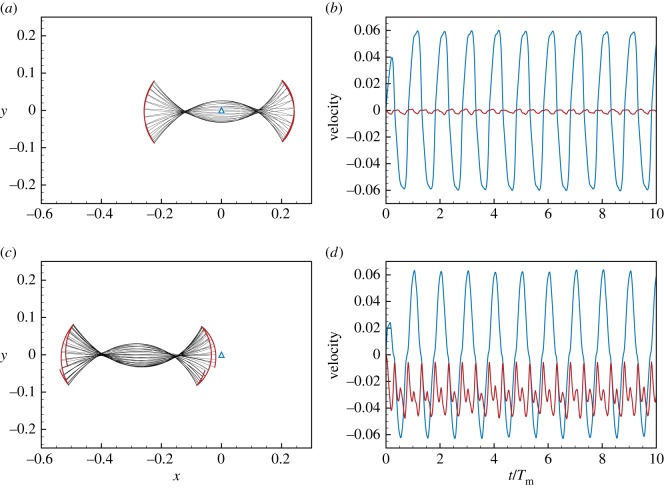
Isotropic versus anisotropic friction driven locomotion. (a) Gait envelope computed over the 10th muscular activation cycle in the case of isotropic friction. The blue triangle denotes the location of the snake’s centre of mass at time t=0, reported as reference. (b) Lateral (blue) and forward (red) velocities as functions of time normalized by the activation period Tm in the case of isotropic friction. (c) Gait envelope computed over the 10th muscular activation cycle in the case of anisotropic friction. The blue triangle denotes the location of the snake’s centre of mass at time t=0, reported as reference. (d) Lateral (blue) and forward (red) velocities as functions of time normalized by the activation period Tm in the case of anisotropic friction. Settings: length L=0.5 m, radius r= 0.025 m, mass m=1 kg, Young’s modulus E=107 Pa, shear modulus G=2E/3 Pa, shear/stretch matrix S=105×1 N, bend/twist matrix B=diag(EI1,EI2,GI3) Nm2, dissipation constant γ= 10−1 kg (ms)−1, gravity g=9.81 m s−2, static μfs=0.2, μsr=μsf, μsb=μsf and kinetic μfk=0.1, μkr=μkf, μkb=μkf friction coefficients in the isotropic case, static μfs=0.2, μsr=2μsf, μsb=20μsf and kinetic μfk= 0.1, μkr=2μkf, μkb=20μkf friction coefficients in the anisotropic case, friction threshold velocity vϵ=10−8 m s−1, ground stiffness and viscous dissipation kw=1 kg s−2 and γw=10−6 kg s−1, discretization elements n=100, timestep δt= 10−5 s, muscular activation period Tm=1 s, wavelength λm=∞, phase shift ϕm=0, torque B-spline coefficients βi=0,…,5={0,10,15,15,10,0} Nm.